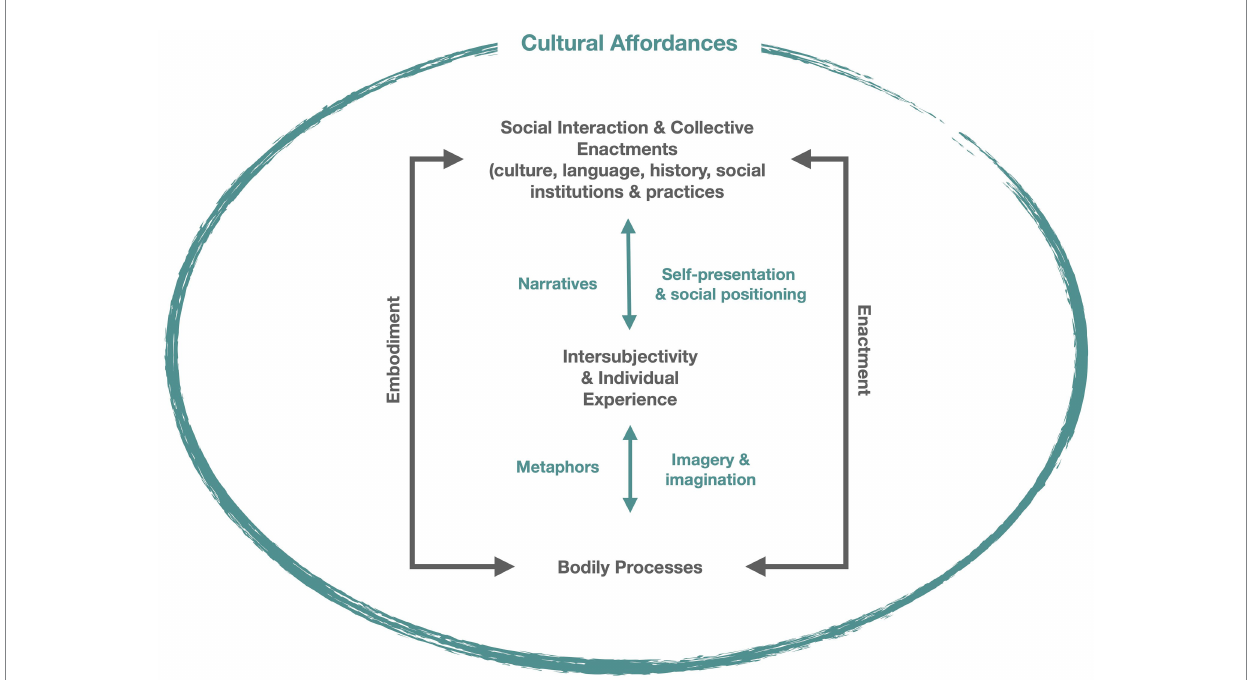
FIGURE 2 Embodied and Enactive Processes of Meaning Making. The figure outlines the cyclical processes of embodiment and enactment that give rise to meaning and experience. Experience emerges through developmental processes and engagement with others in particular social-cultural contexts. There is two-way traffic between bodily processes and individual experience mediated by cognitive processes of metaphoric thinking, imagery and imagination. Similarly, there is traffic between experience and social discourse mediated by interpersonal communication and narrative practices. All of this occurs in a field of cultural affordances provided by local niches and larger social contexts (Adapted from Figure 20.1 in (204); originally published in Embodiment , Enaction , and Culture : Investigating the Constitution of the Shared World , edited by Christoph Durt, Thomas Fuchs, and Christian Tewes, reprinted courtesy of The MIT